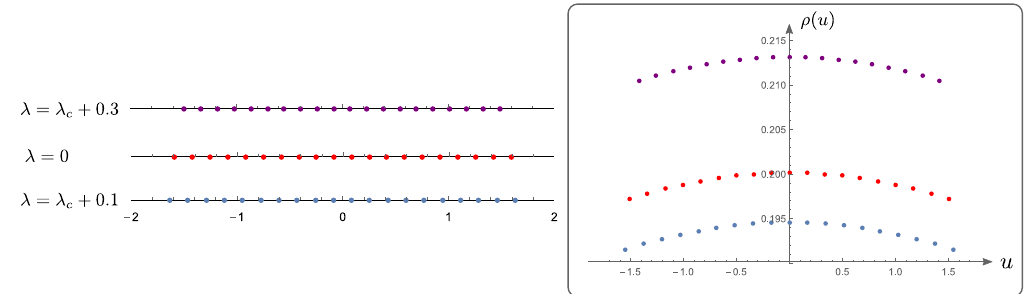
Figure 6: Distribution of Bethe roots for N = 20, R = 30 and c = 5. We plot the root distribution for three different λ , where we take λ to be the critical point of the free c fermion point. The left panel gives the position of the roots on the real axis. The right panel shows the corresponding densities of the rapidities. We see clearly the Bethe roots are more and more condensed while increasing λ